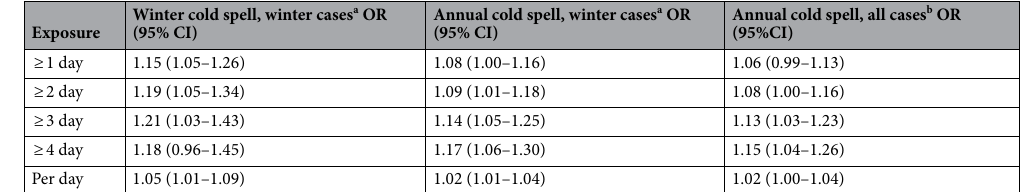
Table 5. Results of the sensitivity analyses using different calendar times for the cold spell definition and assessment, expressed as odds ratios and 95% confidence intervals. a Identically with the main analyses of the study, analysis is limited to cases occurring during the winter months. b Analysis includes cases occurring on all months (n = 16,071).